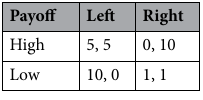
Table 1. Payoff matrix in PD